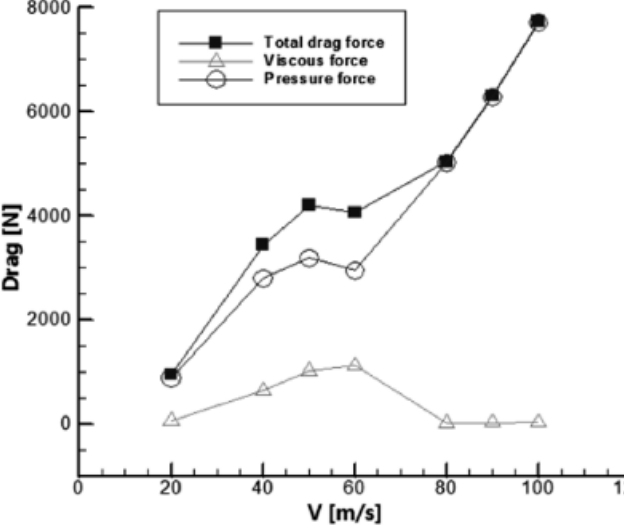
Figure 17. Prediction of drag change according to velocity change.